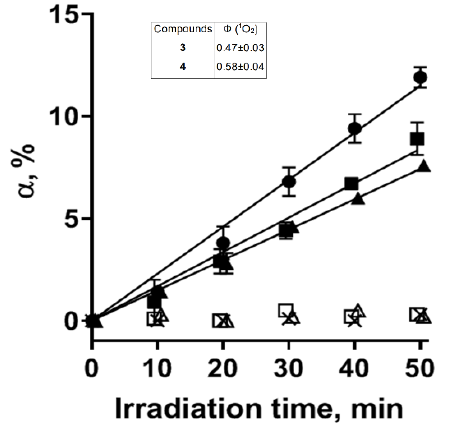
Figure 4. Photoinduced production of singlet oxygen and · OH-radicals by chlorin p 6 thioanhydride ( 3 ), or chlorin p 6 selenoanhydride ( 4 ) in 1% micellar solutions of Kolliphor ELP. The RNO bleaching ( α ) by · OH radicals in the presence of chlorin p 6 thioanhydride ( 3 ) or chlorin p 6 selenoanhydride ( 4 ) (open triangles and open squares, respectively). The RNO bleaching induced by the reaction of singlet oxygen with histidine in the presence of Rose Bengal (filled circles), chlorin p 6 thioanhydride ( 3 ) (triangles), and chlorin p 6 selenoanhydride ( 4 ) (filled squares), chlorin p 6 thioanhydride ( 3 ), or chlorin p 6 selenoanhydride ( 4 ) and sodium azide (crosses). Φ ( 1 O 2 ) is the quantum yield of singlet oxygen generation.